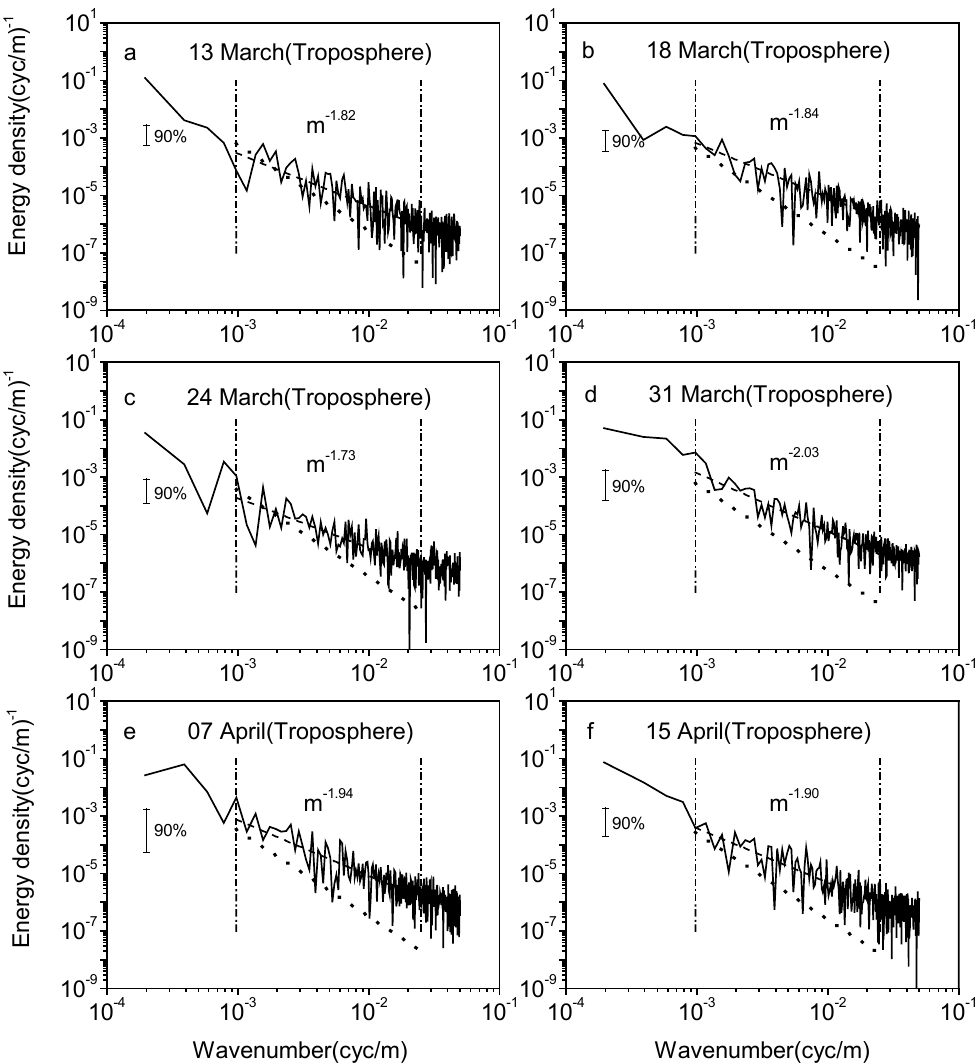
Fig. 2. Vertical wave number spectra of normalized temperature fluctuations observed in the troposphere. The dashed lines are the best fit approximately by a straight line. The thick dotted straight lines show the saturated spectral amplitudes predicted by Eq. (2). The confidence intervals for the 90% level are given in these figures by the vertical